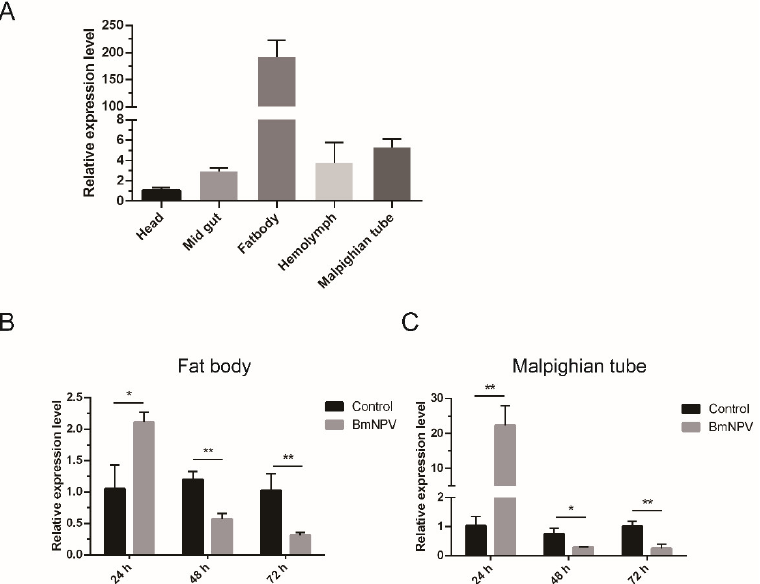
Figure 3. The expression profiles analysis of B. mori IML-2 . ( A ) The mRNA levels of BmIML-2 in various tissues. ( B , C ) Inducible expression profiles of BmIML-2 in fat body and malpighian tube upon BmNPV infection. The RNA samples of different tissues were extracted individually as described above. Then, the prepared RNA samples were converted into cDNA for qRT-PCR assay. The B. mori GAPDH gene was used as an internal reference. Error bars represent means ± S.D. of three independent values, and the asterisks indicate significant differences compared with the control group (unpaired t -test; *, p < 0.05; **, p < 0.01; ns, not significant).